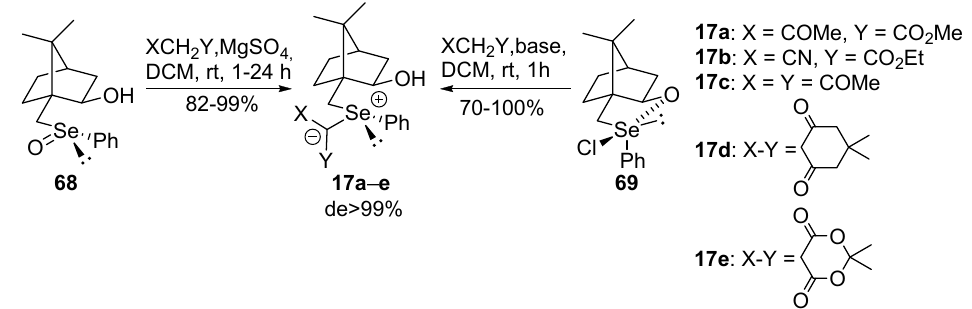
Scheme 20. Reaction of optically active selenoxide 68 and chloroselenurane 69 with activated methylene compounds.